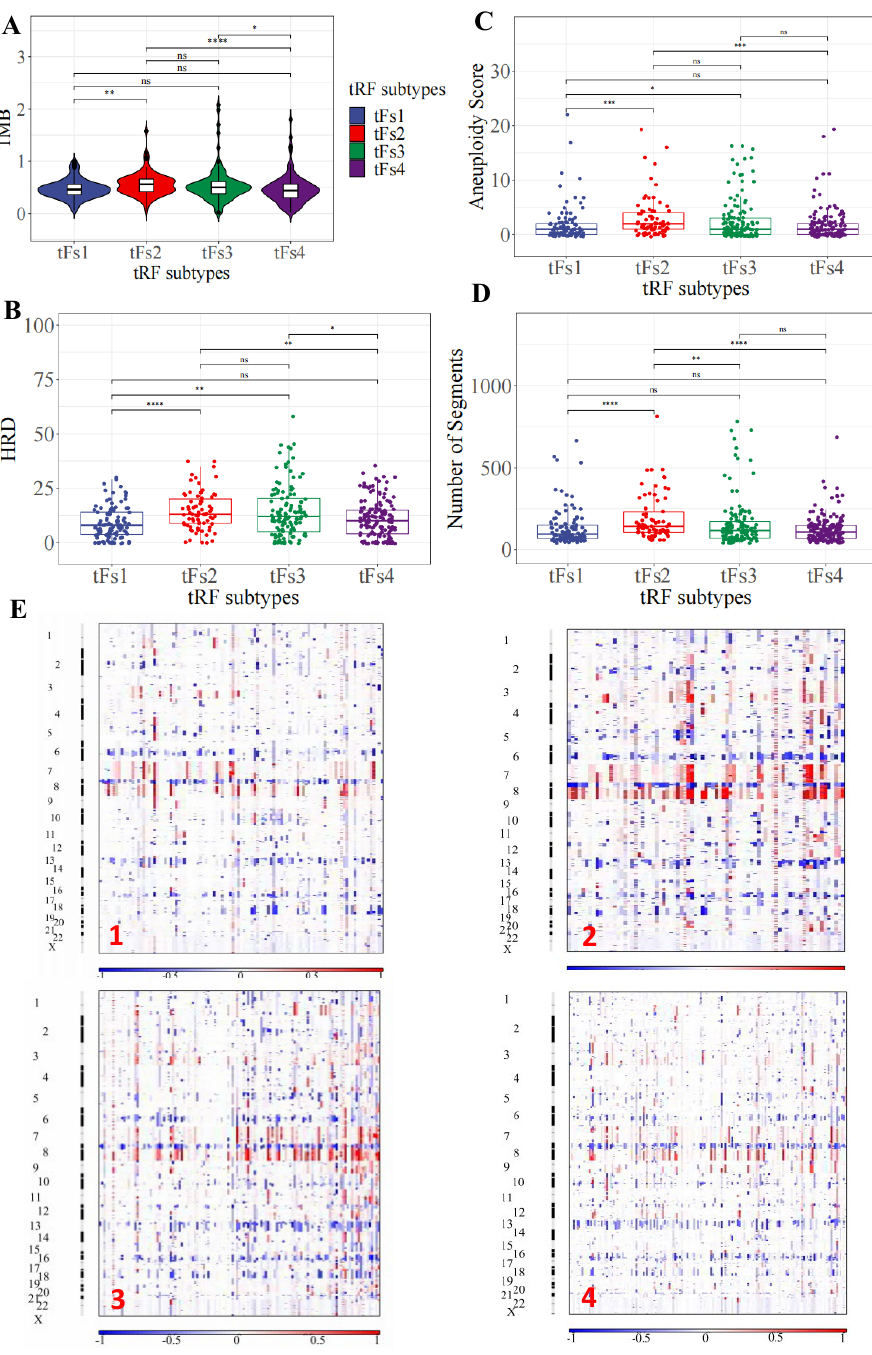
Figure 6. Distinct genomic landscapes among 5ʹ-tRFs tumor subtypes. ( A ) Tumor mutation burden. The TMB was estimated by the number of non-synonymous somatic mutations (single nucleotide variants and small insertions/deletions) per Mb in protein-coding regions. ( B ) Homologous recombination defects. The HRD score was calculated by summing three DNA-based measures of genomic instability: large (>15 Mb) non-arm-level regions with LOH, large-scale state transitions (breaks between adjacent segments of >10 Mb), and subtelomeric regions with allelic imbalance. ( C ) Aneuploidy score. The AS is the total number of arm-level gains and losses for a tumor, adjusted for ploidy. ( D ) Number of segments. The number of segments was the total number of segments in each tumor’s copy number profile. * p < 0.05, ** p < 0.01, *** p < 0.001, **** p < 0.0001, ns: nonsignificant. ( E ) Somatic copy number variation. Chromosomes are represented along the vertical axis, samples are arranged horizontally; red indicates copy number amplification and blue indicates copy number